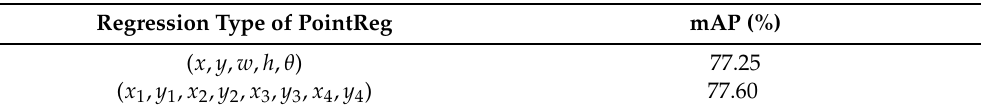
Table 7. Analysis of the effectiveness of OBB regression type of PointReg. The metric mAP was evaluated for the DOTA-v1.5 test set.